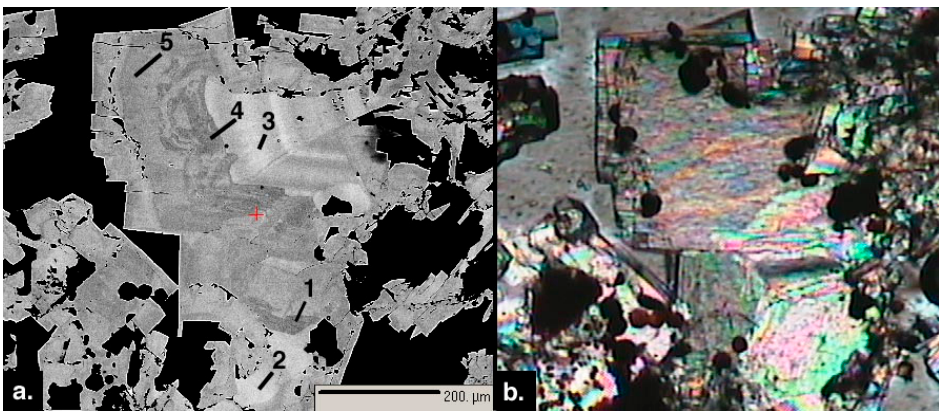
Figure 1. ( a ) Backscattered scanning electron micrograph; and ( b ) transmitted optical micrograph of zoned willemite in sample TM-06-15. Numbers indicate location of analyses in Table S1. Note the chemical zonation is not observable optically.